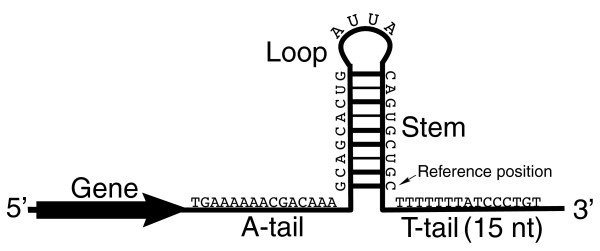
Schematic of the terminator motif for which TransTermHP searches. The terminators consist of a short stem-loop hairpin followed by a thymine-rich region on their 3' side. For the results reported here, TransTermHP was restricted to find terminators for which each side of the stem is ≥ 4 nt, the length of the loop is ≥ 3 nt and ≤ 13 nt, and the total length of the stem-loop was ≤ 59 nt.